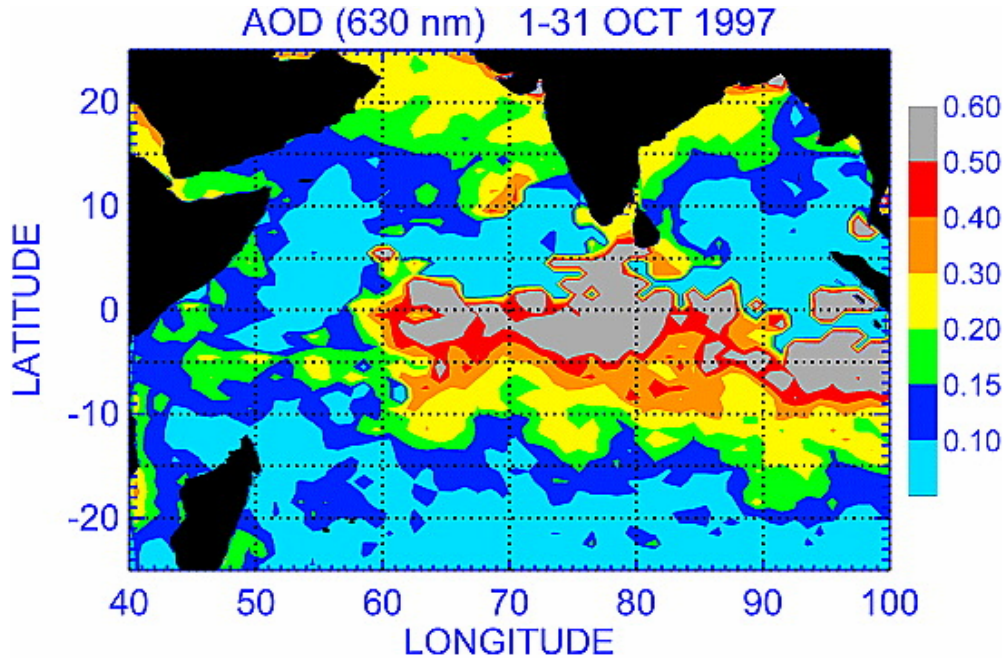
Fig. 50. Satellite retrieval of the aerosol optical depth (AOD) during October 1997, showing the strong plume from the Indonesian forest fires (from Li and Ramanathan, 2002, copyright 2002 by the American Geophysical Union, reproduced with